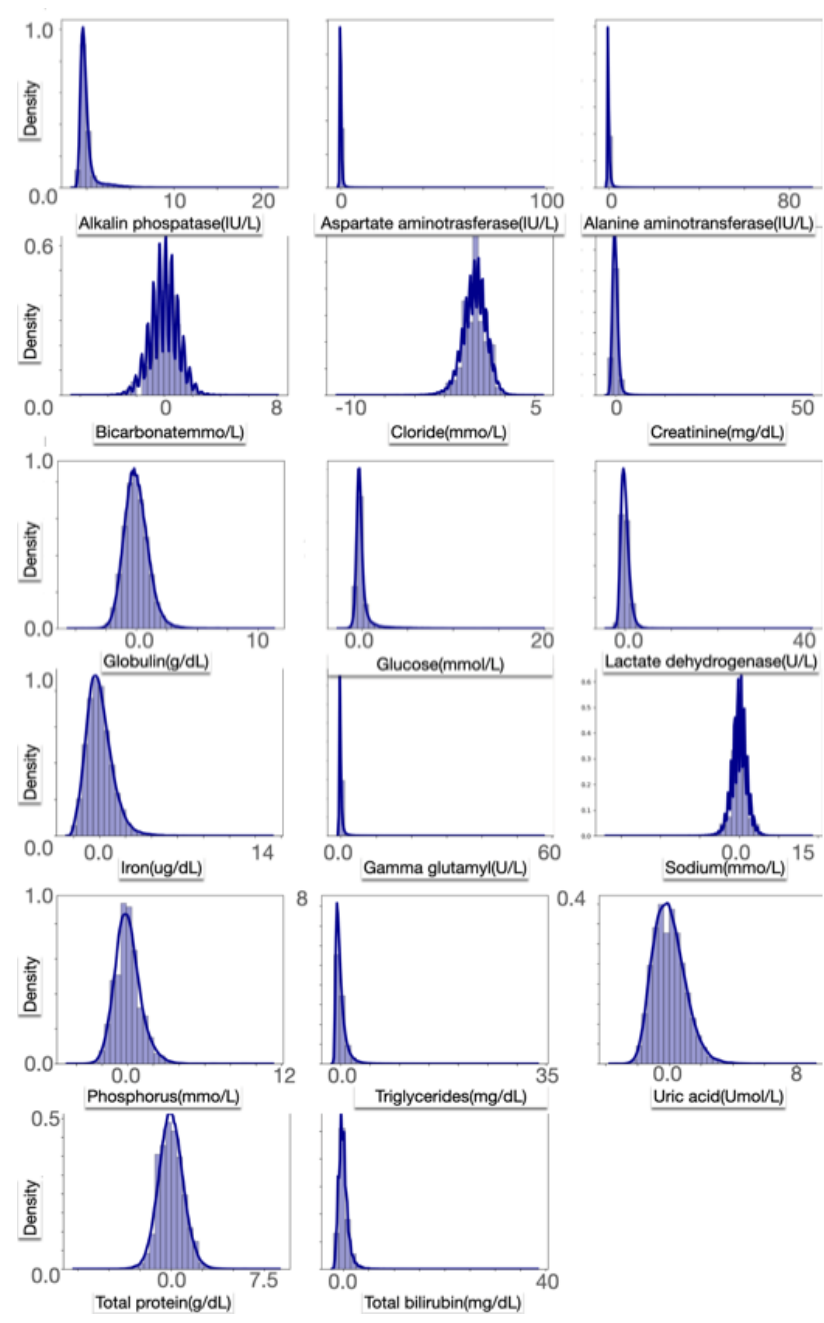
Figure 7. Histograms and densities of blood